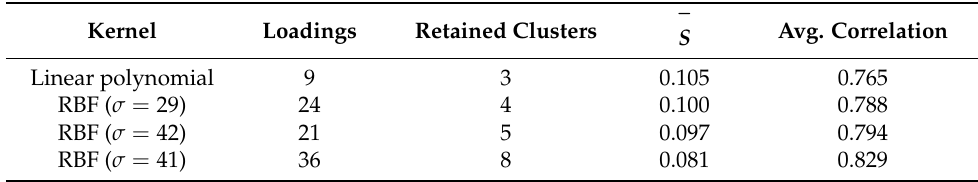
Table 2. Same as Table 1, but for the best KPCA configuration. No results for six or seven clusters outperformed the baseline, so the values were not provided. The loadings column refers to the number of retained loadings for the optimal KPCA